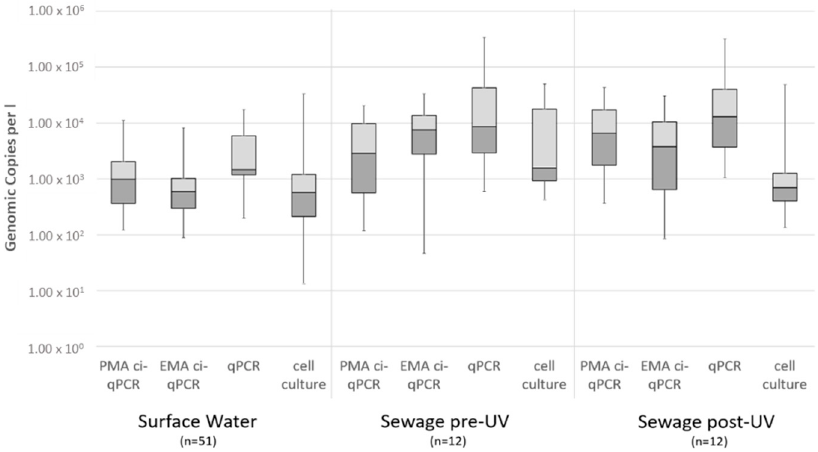
Figure 2. Concentration of HAdV in surface water as well as pre- and post-UV treatment, obtained by ci-qPCR using either EMA or PMA followed by qPCR (using the Heim et al. [50] protocol, stated as gene copies per liter of sample) and cell culture (as TCID 50 per liter). 25- and 75-percentile, median value as well as minimum and maximum; error bars represent the standard deviation. Limit of detection has been calculated as 25 genomic copies per L of sample for molecular methods and 2 infectious virions per mL for the cell.